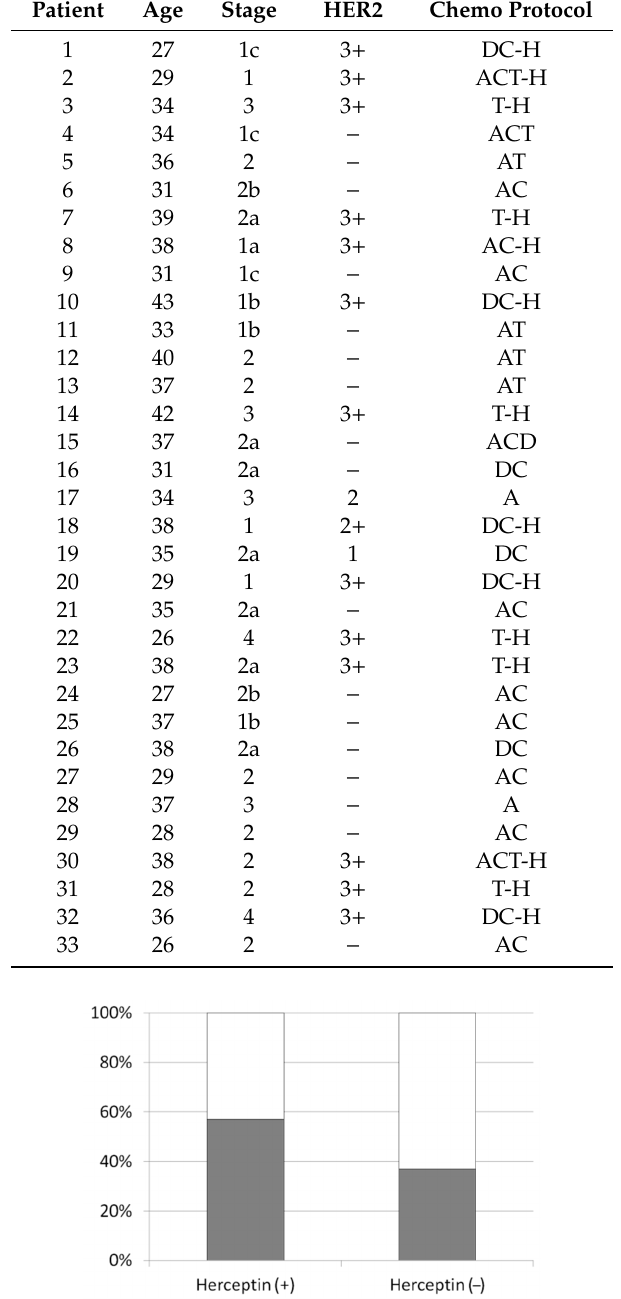
Figure 5. Anti-HER2 / neu protection from chemotherapy-induced ovarian toxicity in cancer patients. Serum AMH in breast cancer patients who were treated or not treated with trastuzumab. Positive AMH levels were detected in 57.1% of the Herceptin treated patients compared with 36.8% in the non trastuzumab group ( p <